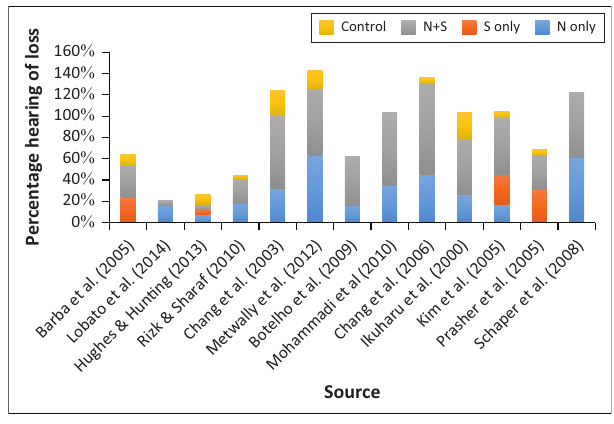
FIGURE 1: Prevalence of hearing loss among four